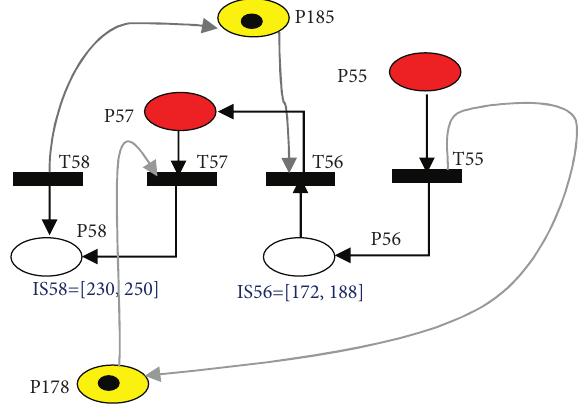
Figure 6: Catch-up places P